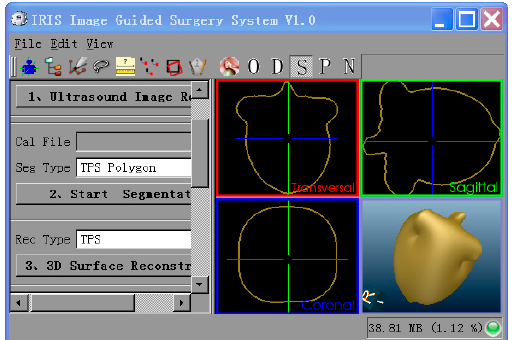
Figure 3. Reconstruction and visualization